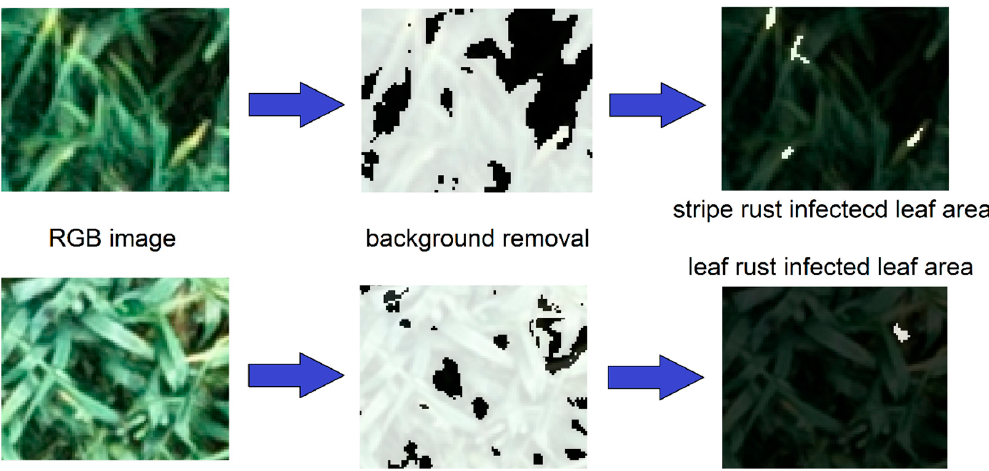
Figure 2. The proposed approach to determine stripe rust and leaf rust infected pixels. Unmanned aerial vehicle based Red-Green-Blue (RGB) image ( left ), removing the background effect (classified as black color pixels) from the true vegetation (classified as gray color) pixels ( middle ), and estimation of pixels infected by stripe rust (identified as white color pixels) based on the stripe rust index ( top right ) as well as the pixels infected by leaf rust (identified as white color pixels) based on the leaf rust index ( bottom right ).